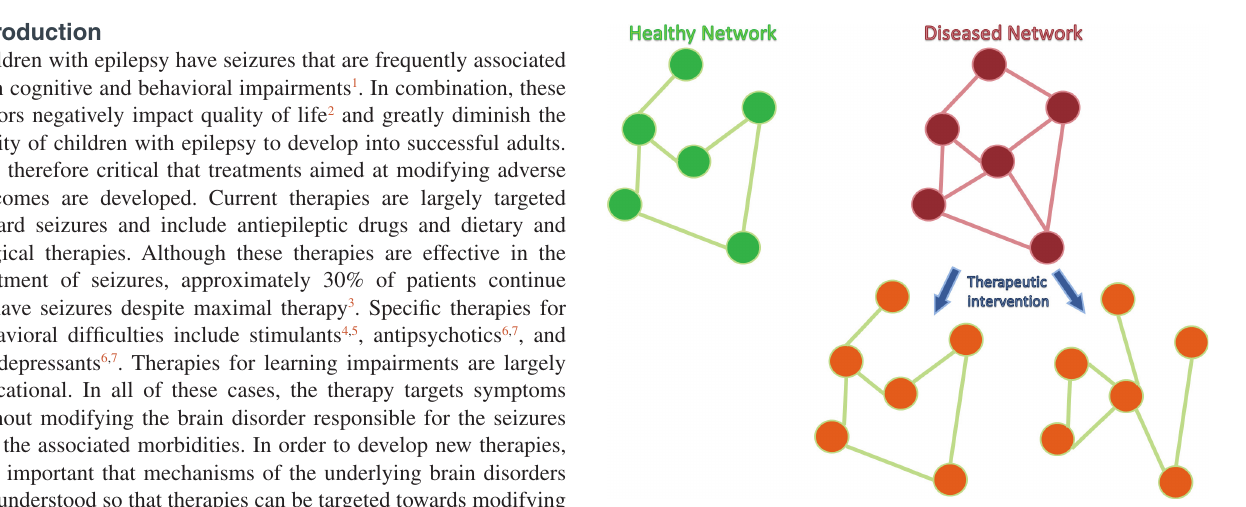
Figure 1. Cartoon representing healthy and diseased networks. Each node in the network could represent a gene, transcriptional module, single neuron, or brain region. The lines between the nodes represent relevant interactions between the nodes. Conceptually, the structure of the network is different in disease states compared to controls. In this example, the diseased network is over-connected (e.g. hypersynchrony in an epileptic brain). Targeting the network directly using drugs, brain stimulation, cell therapy, or transcranial magnetic stimulation approaches could modify the diseased network in order to allow more normal function. It remains unknown whether restoration of networks to normal (left network post-therapy) or modification to a network with similar phenotype to normal (right network post-therapy) is required. Understanding of these system- level mechanisms could lead to new treatments or optimization of currently used clinical tools, such as deep brain